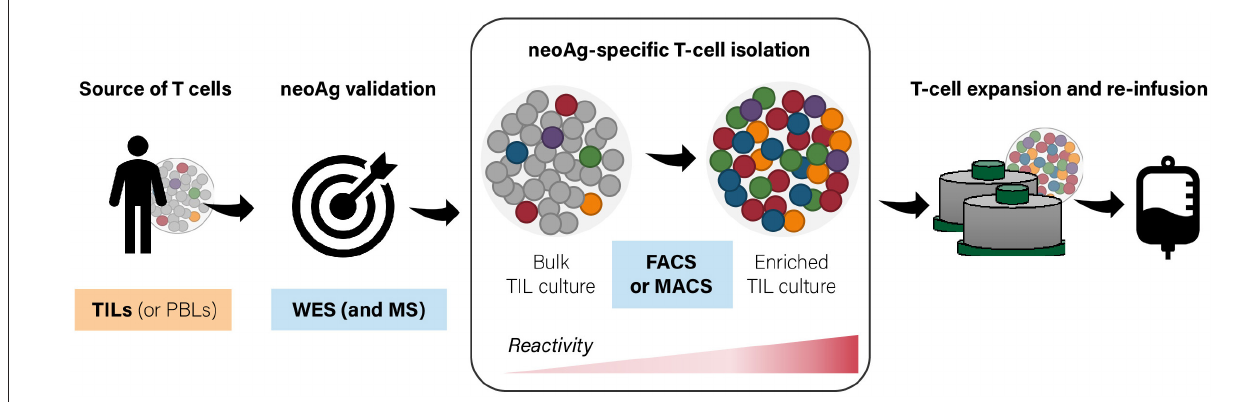
FIGURE 1 | General workflow for personalized enrichment of antigen-specific T-cells from bulk tumor-infiltrating lymphocyte (TIL) [or peripheral blood lymphocyte (PBL)] cultures. T-cells can be isolated from the patient’s infiltrating or circulating lymphocyte populations. Following neoantigen discovery and validation, antigen-specific T-cells are enriched by bulk cultures and expanded in vitro to meet the numbers required for reinfusion. FACS, fluorescence-activated cell sorting; MACS, magnetic bead-activated cell sorting; WES, whole-exome sequencing; MS, mass spectrometry.